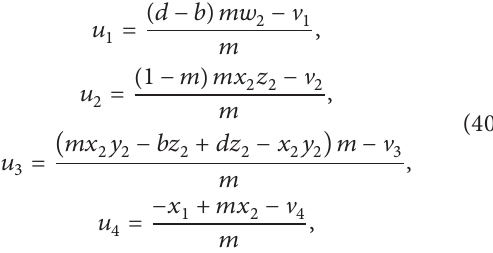
Figure 11: The solutions of the master and slave systems with control law. (a) Signals 𝑥 1 (the dashed line) and 𝑥 2 (the solid line). (b) Signals 𝑦 1 (the dashed line) and solid